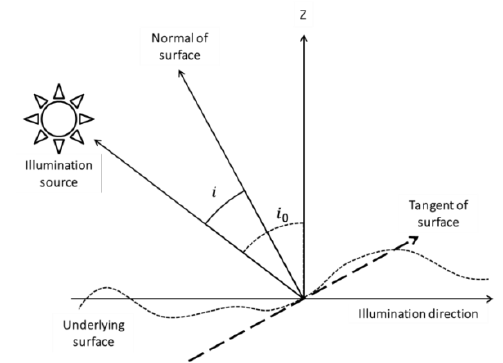
Figure 4. Illustration of the relationship between the surface slope and illumination source